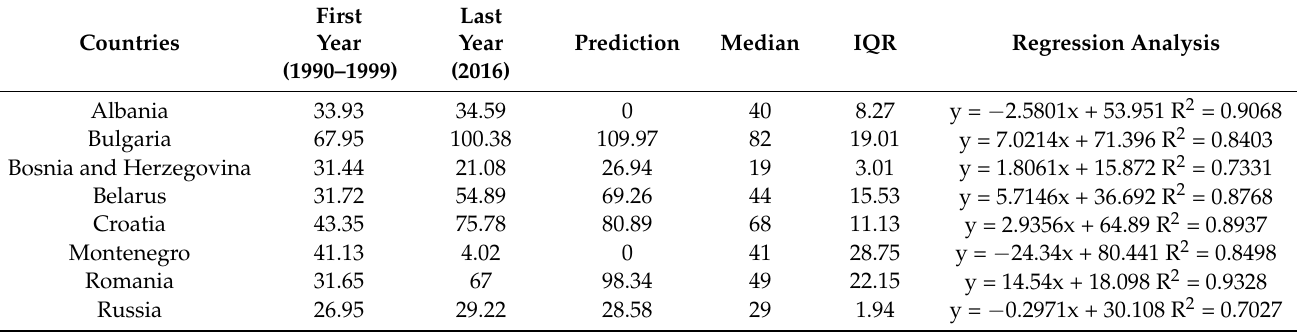
Table 4. Values of the number of dentists working per 100,000 inhabitants—value of the first observed year, last observed year, predictive value, median value, inter-incremental difference and linear regression